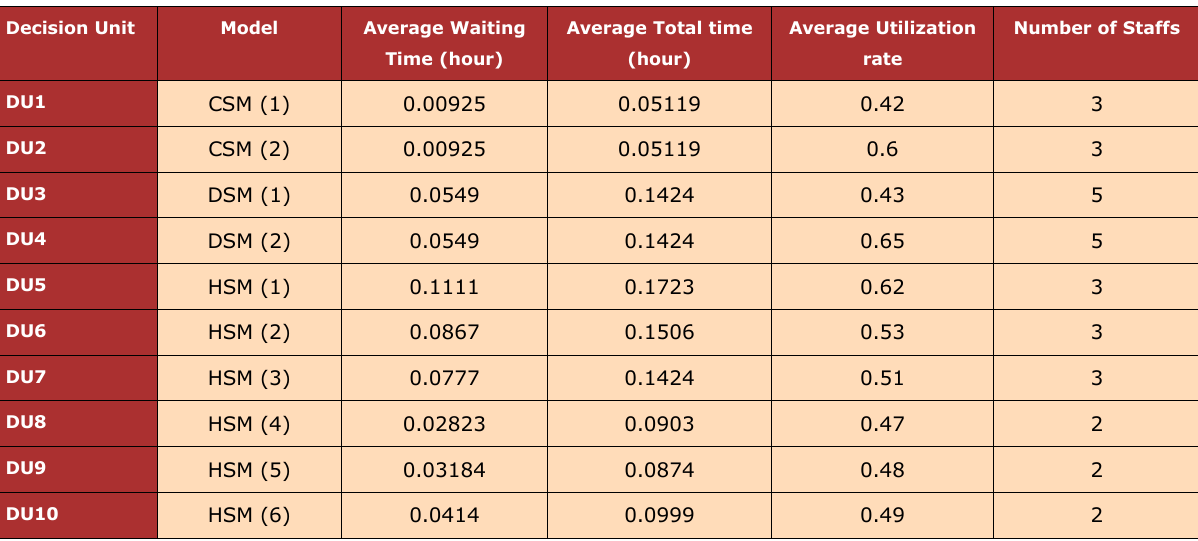
Table 4. Simulation outputs for the setting with high